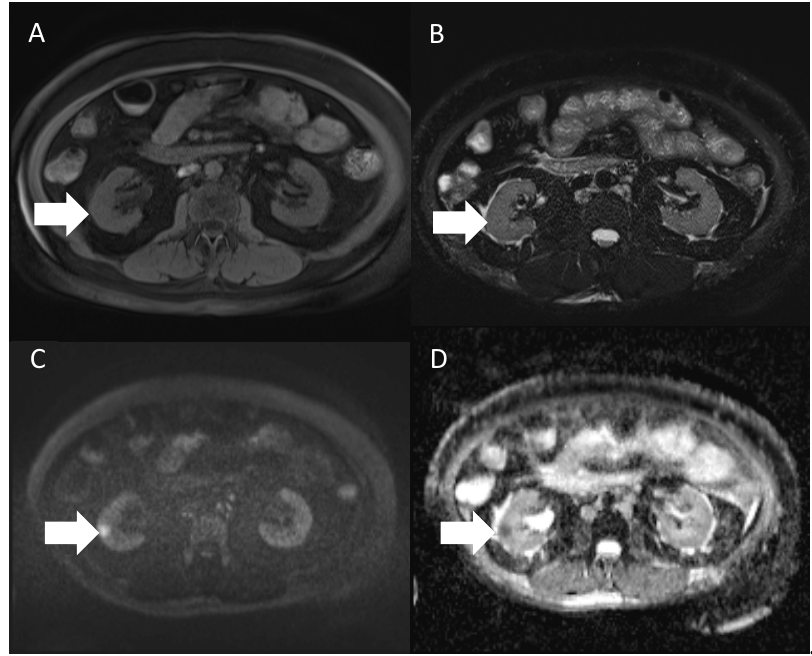
Figure 2. Non-contrast enhanced magnetic resonance imaging (MRI) of this case. The lesion (arrow) shows relatively isointense on both T1-weighted imaging with fat saturation ( A ) and T2-weighted imaging ( B ), with high signal intensity on diffusion-weighted imaging ( C ) and low-value appearance on apparent diffusion coefficient imaging ( D ).